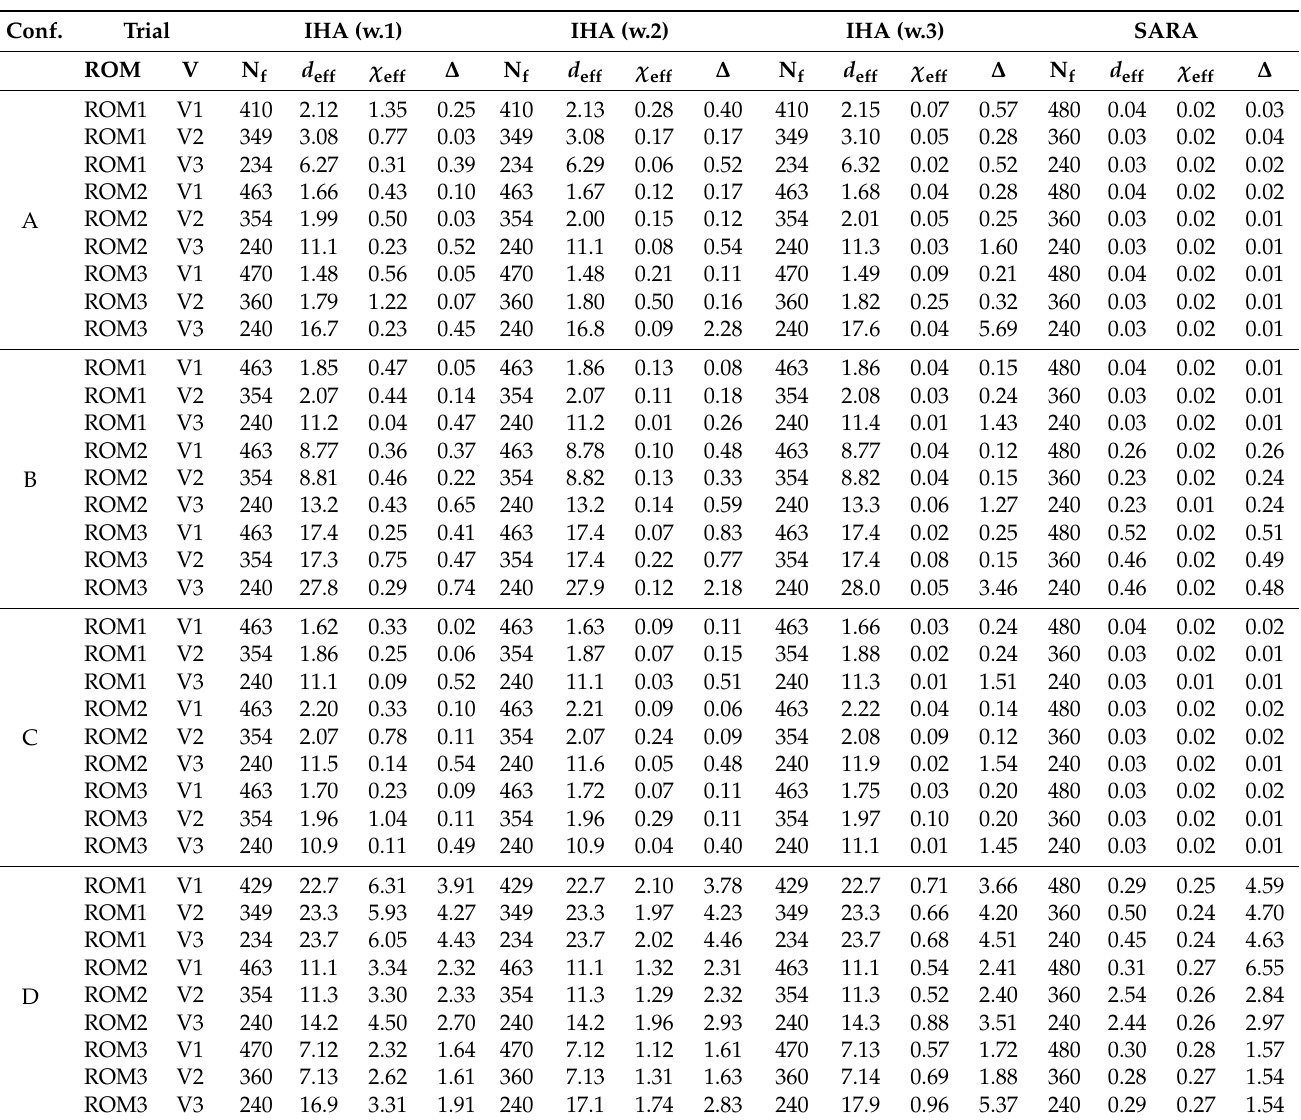
Table A1. Dispersion parameters ( d eff , in mm, and χ eff , in deg) and rms distance ( ∆ , in mm) between exact and estimated AoRs, for different ROMs and speeds tested. Results are given for A–D motion configurations; the corresponding ranges (ROM1 . . . ROM3) and speeds (V1 . . . V3) are detailed in Section 2.3.2. For each algorithm, the resulting number of time frames N f is